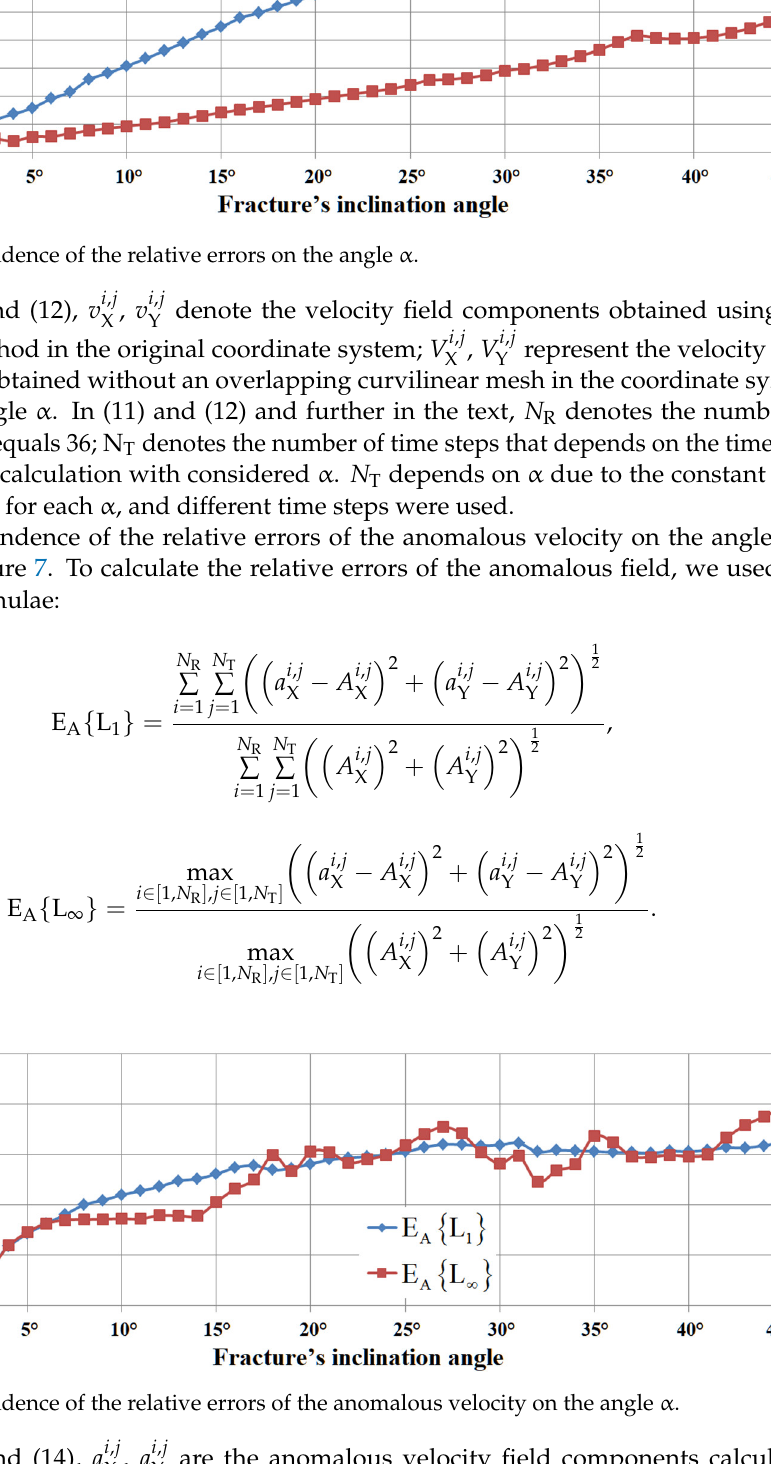
, A i , j are the anomalous X Y